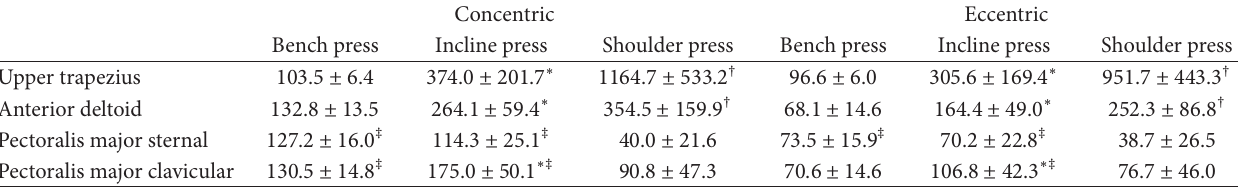
Table 3: Mean ± standard deviation activation amplitude across all subjects ( 𝑛 = 24 ) for each muscle by exercise phase expressed as a percentage of the mean ensemble averages of the bench press (entire repetition). With the exception of the pectoralis major sternal, concentric activation amplitude was significantly greater than eccentric activation amplitude within each